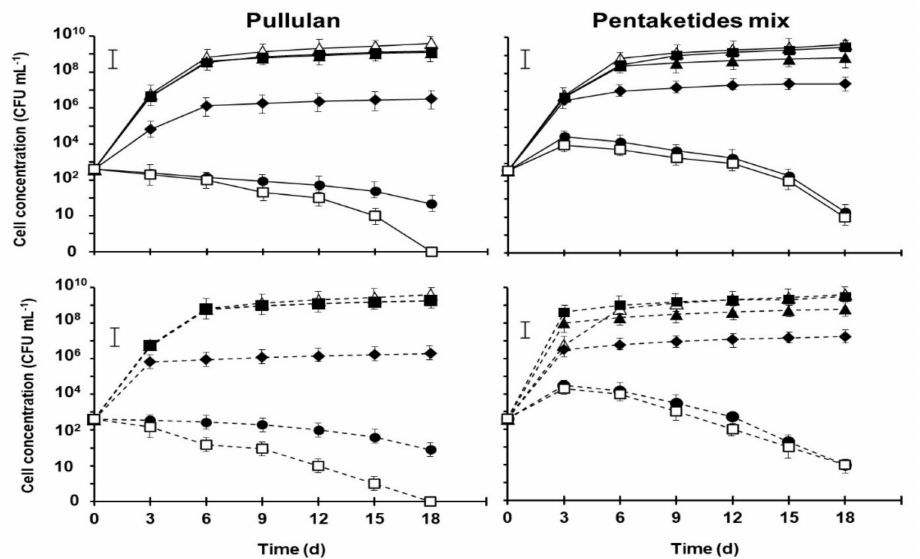
Figure 2. Growth curves of Saccharomyces cerevisiae strains Byosal HS1 (—) and IOC 18-2007 (---) growth on synthetic must containing 0 ( ), 1 ( ), 5 ( ▲ ), 10 ( ), 100 ( ) or 1000 ( ) μ g mL − 1 of pullulan or pentaketides mix (scytalone/isosclerone; 9:1/w/w) during 18 days of fermentation (20